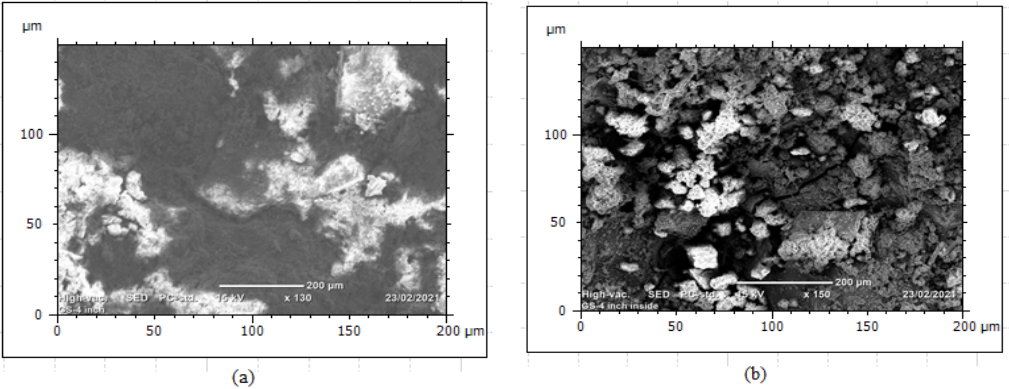
Figure 13. SEM image of corrosion damaged GS pipe: ( a ) external corrosion and ( b ) internal corrosion.